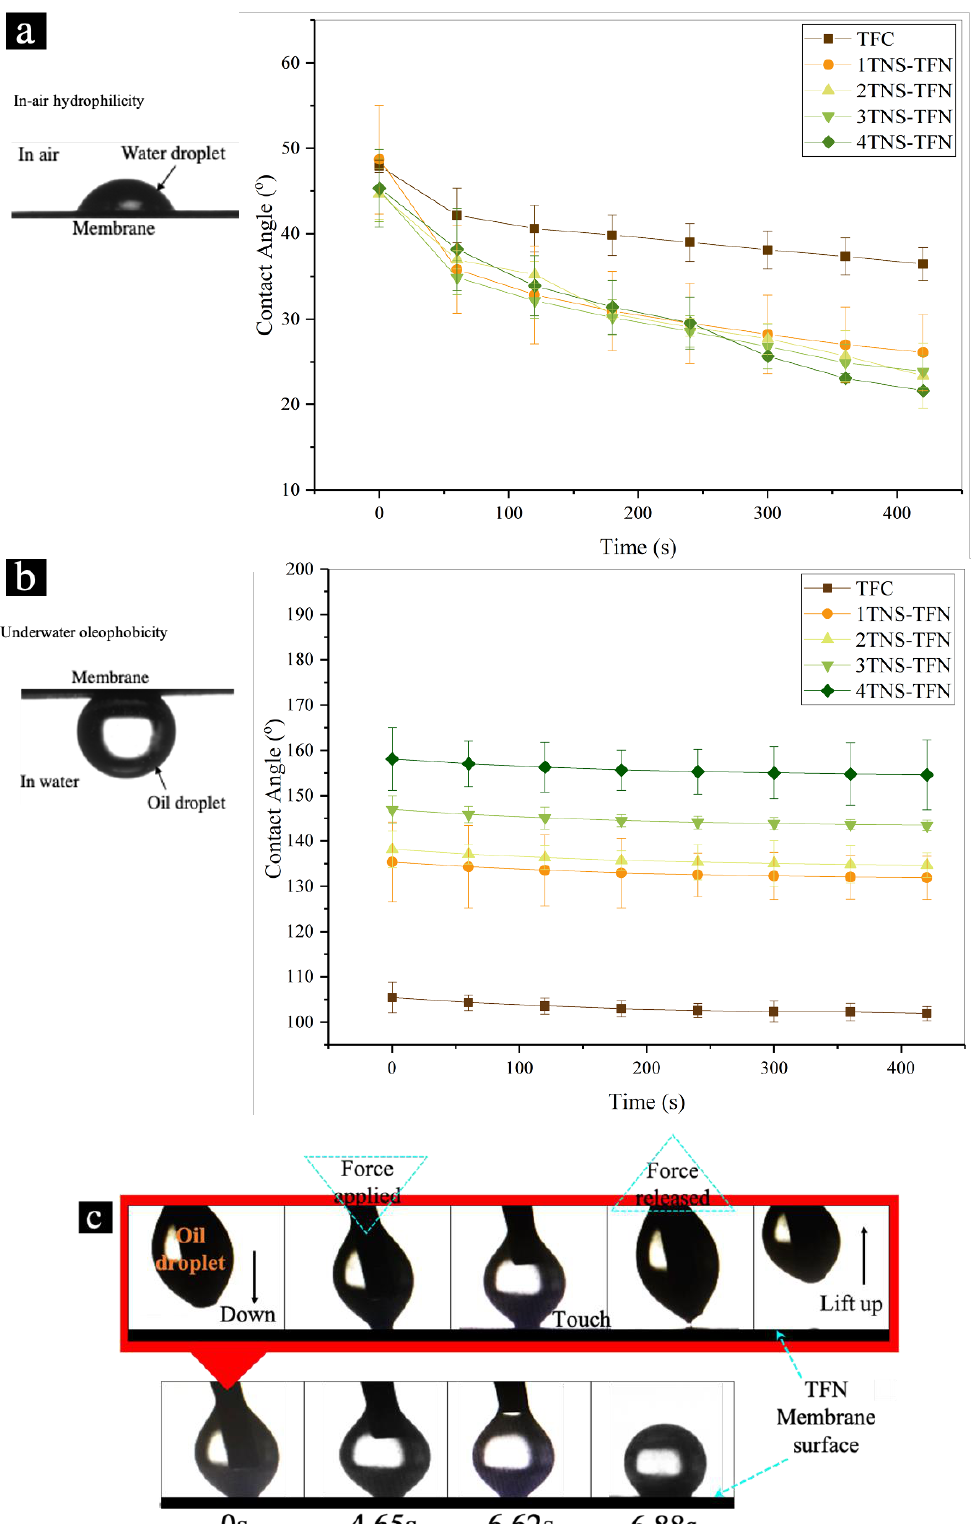
Figure 1. ( a ) Water contact angle with ( b ) underwater oil contact angle of all experimental membranes and ( c ) an “attach-compress-detach” behavioral pattern of oil droplets during contact with all prepared membranes’ surfaces before the values of the underwater oil contact angle can be taken.